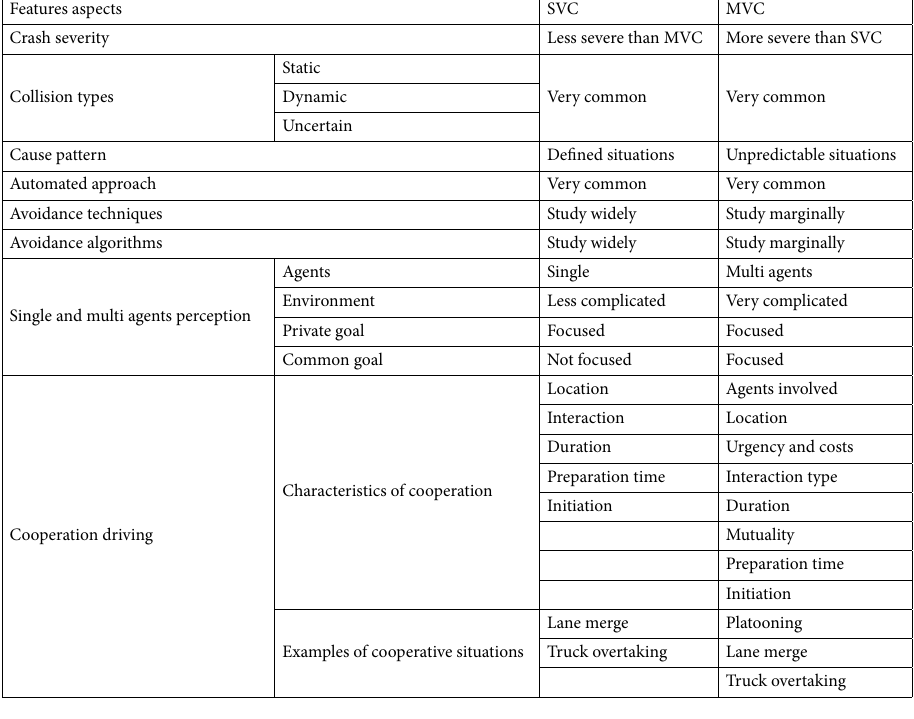
Table 2. Major aspects of SVC and